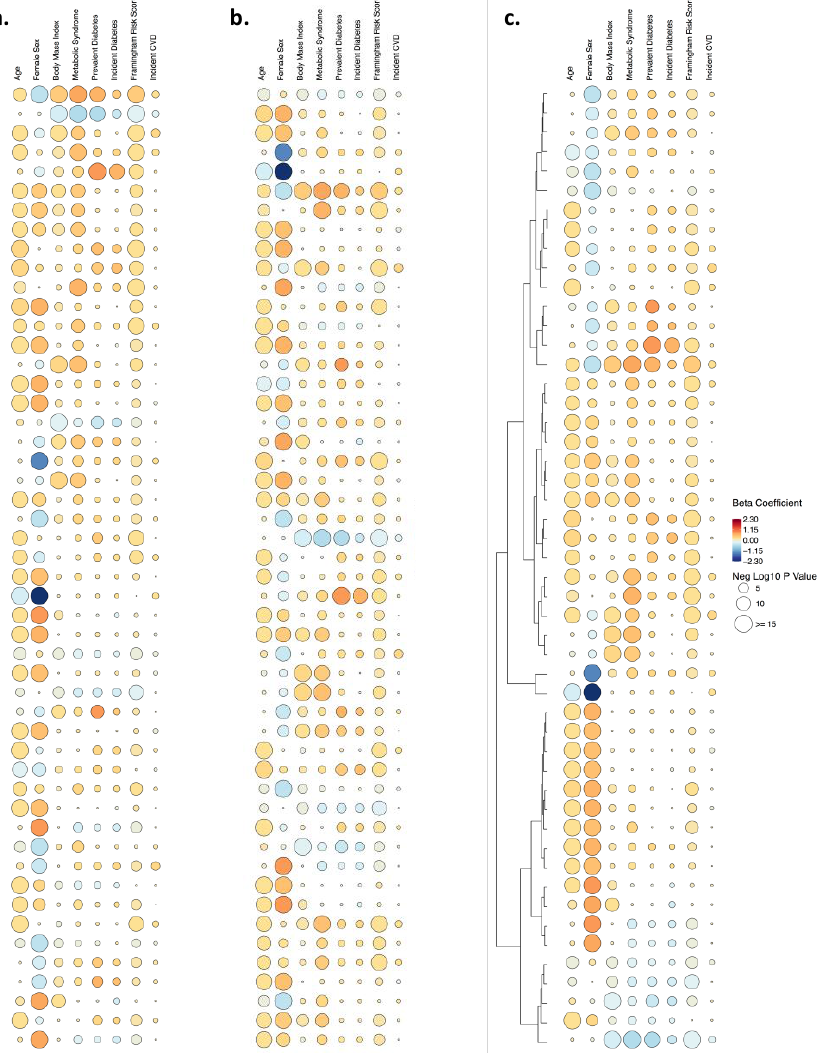
Figure 2. Rain plots. Results are ordered top to bottom by smallest to largest P value ( a ), mass-to-charge ratio ( b ), and by clustering ( c ).